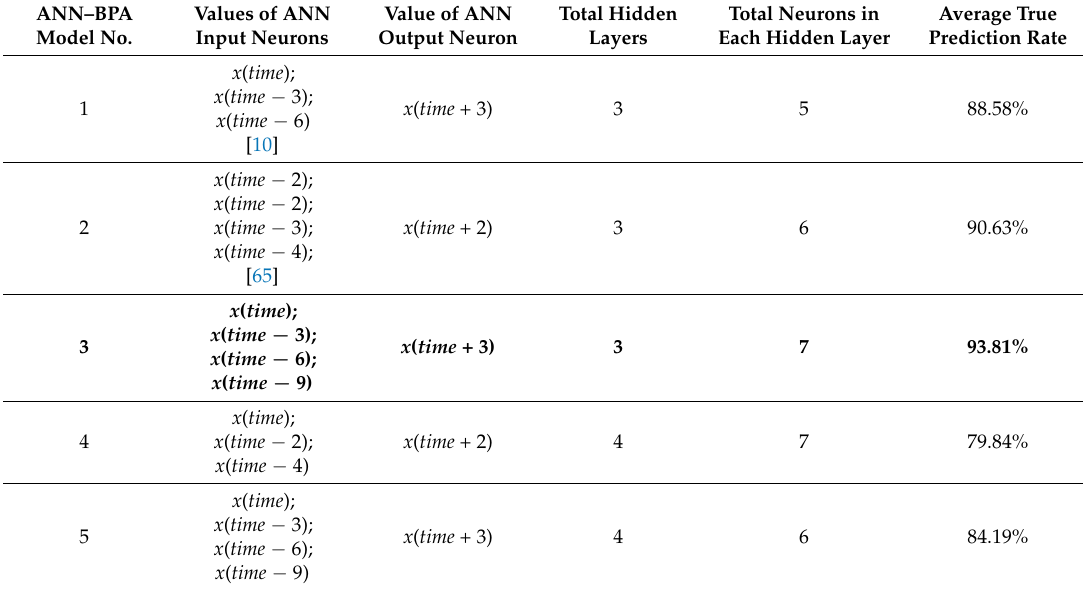
Table 2. Average true prediction rate values of different back propagation algorithm (BPA)-trained ANN models for the EEG time series (Figure 5) in the study. ANN–BPA Model